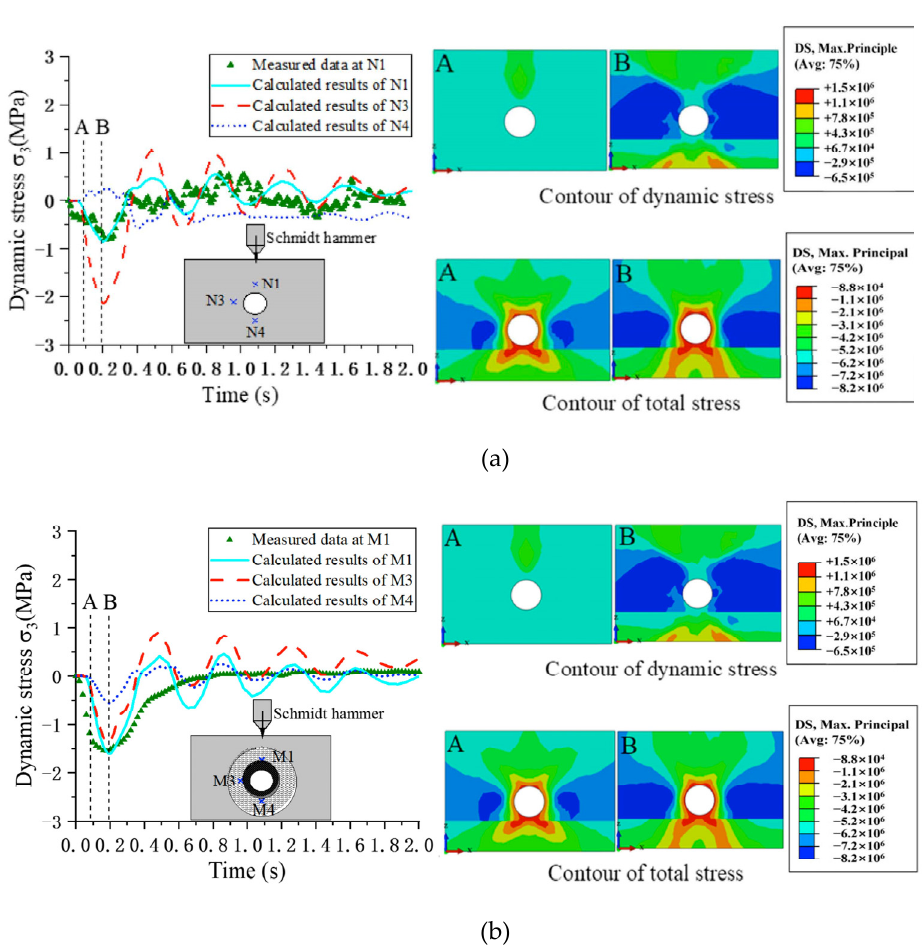
Figure 6. Dynamic stress and contour of stress distribution of ( a ) a normal coal roadway and ( b ) a modified coal roadway under the impact load of a Schmidt